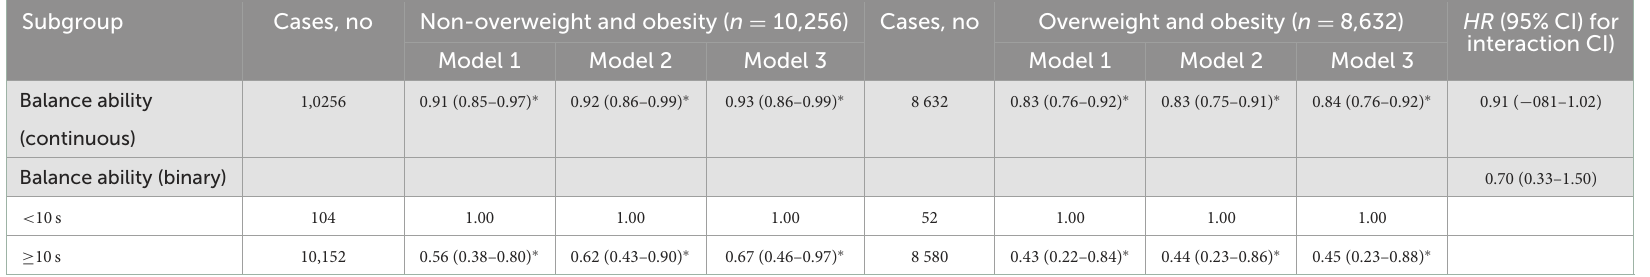
TABLE 3 Cox risk proportional model of death risk among participants who were overweight and obese or not.